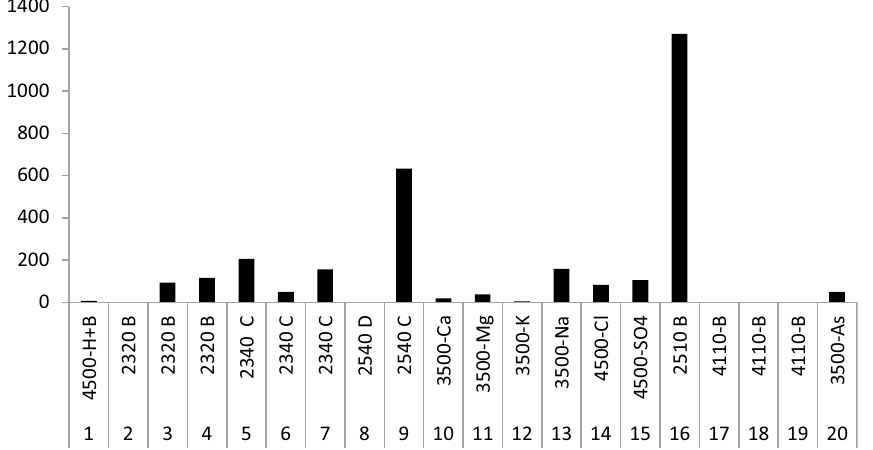
Fig. 1 Results of the data collected for different parameters. 1. pH at 25 °C, 2. total alkalinity as CaCO 3 (meq/L), 3. carbonates (mg/L), 4. bicarbonates (mg/L), 5. total hardness (mg/L), 6. calcium hardness as CaCO 3 (mg/L), 7. magnesium hardness as CaCO 3 (mg/L), 8. total suspended solids (mg/L), 9. total dissolved solids (mg/L), 10. calcium